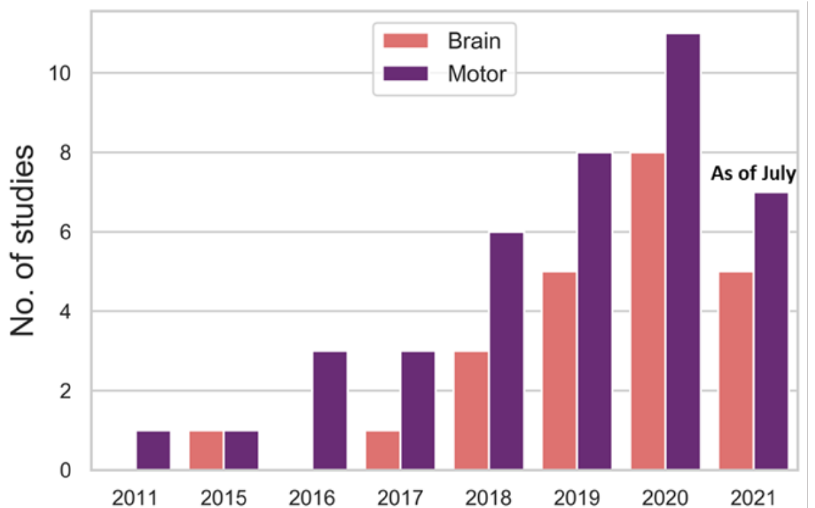
Figure 12. Bar chart representation of the number of deep learning studies published between January 2020 and July 2021 for brain analysis and motor